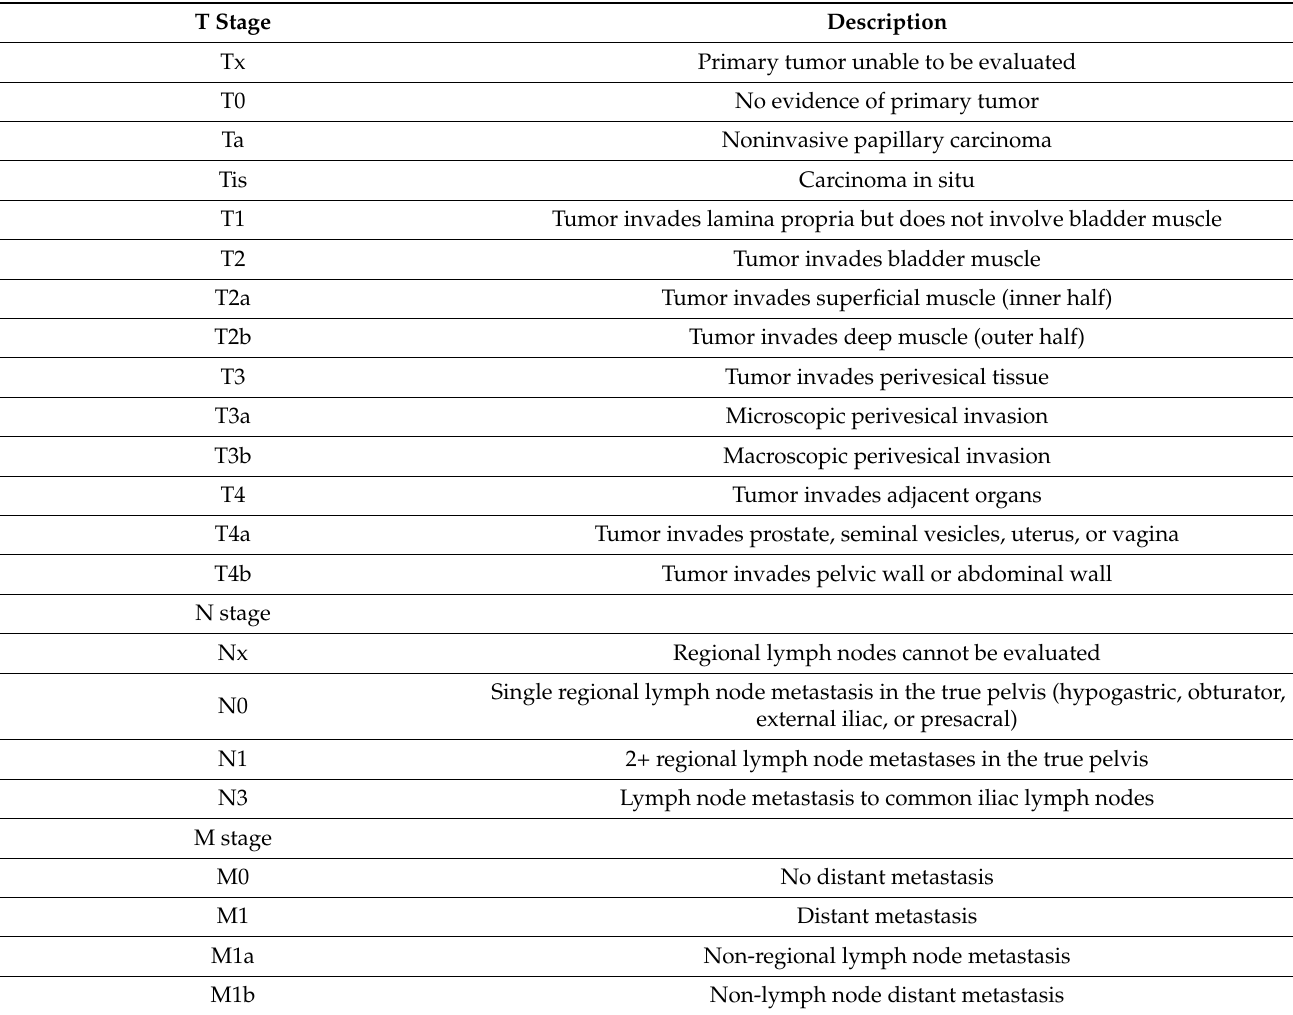
Table 1. AJCC TNM staging (8th